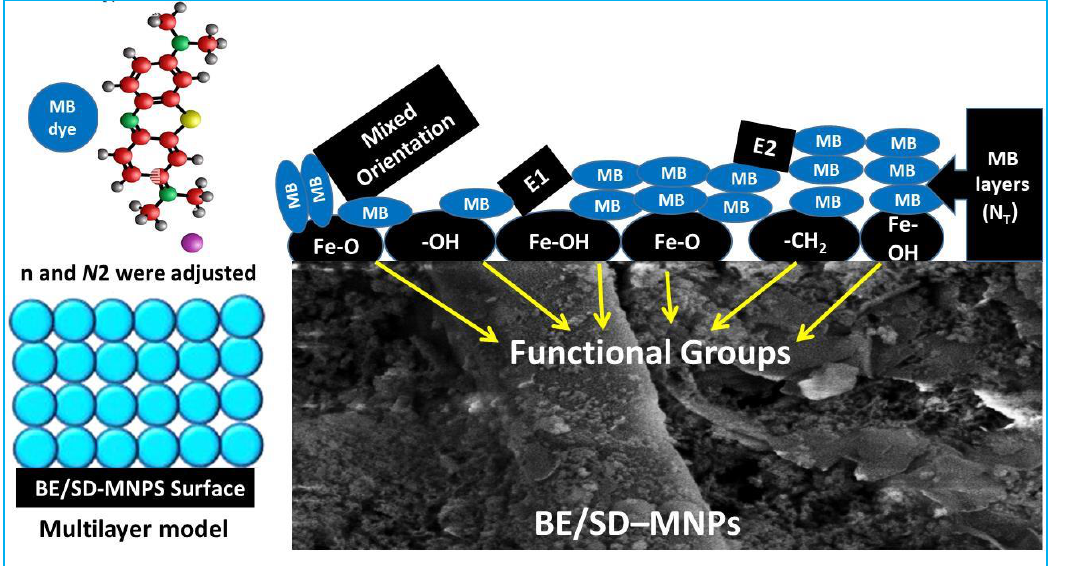
Figure 9. The geometry and adsorption mechanism of MB on the BE/SD – MNPs adsorbent via the multilayer model.